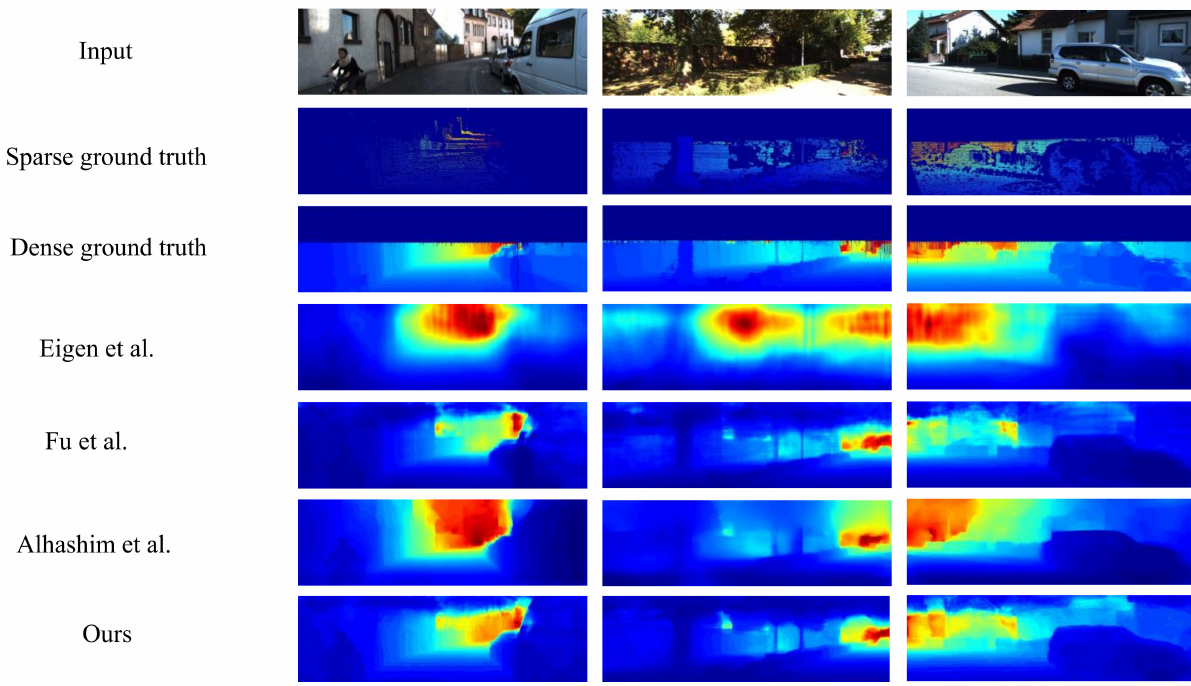
Figure 7. Assessment results for the KITTI dataset from a qualitative perspective. First row: input, second row: sparse ground truth, third row: dense ground truth, fourth row to last row: depths recovered by Eigen et al. [4], Fu et al. [22], Alhashim et al. [55] and our